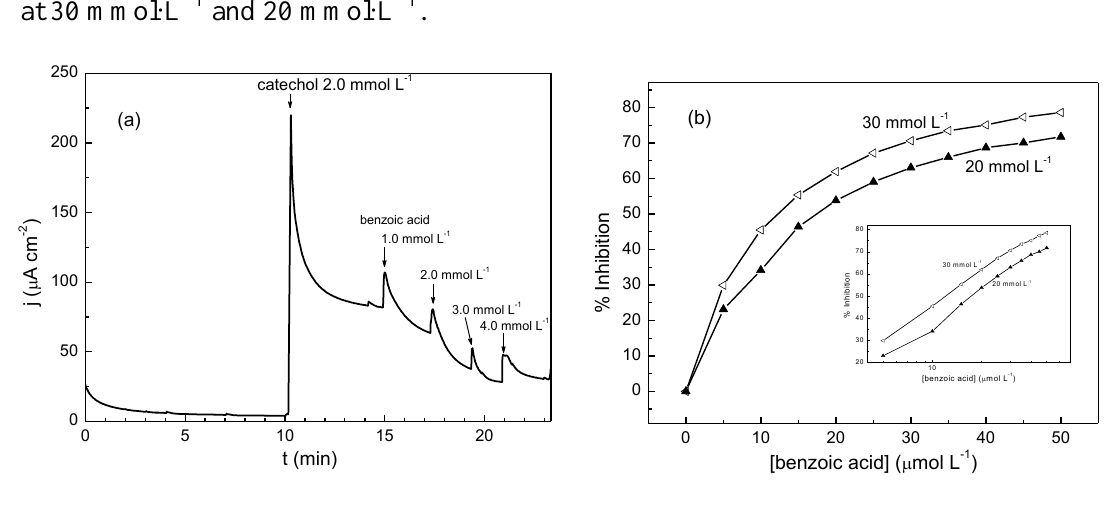
Figure 9. Current responses for PPy/Tyr films at different concentrations of benzoic acid ( a ); ( b ) inhibition percentage vs. concentration of benzoic acid in the presence of catechol at 30 mmol∙L −1 and 20 mmol∙L −1